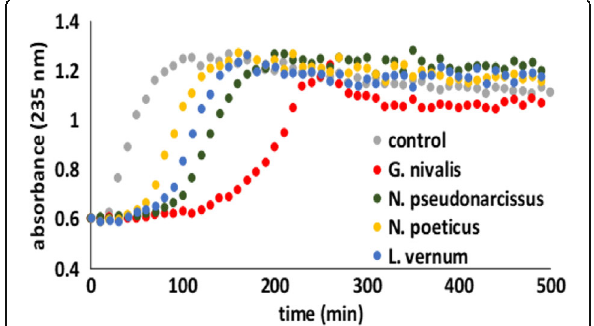
Fig. 7 Liposome oxidation by cytochrome c in the presence of G. nivalis, N. pseudonarcissus, N. poeticus and L. vernum extracts, in phosphate buffer, pH 7, at room